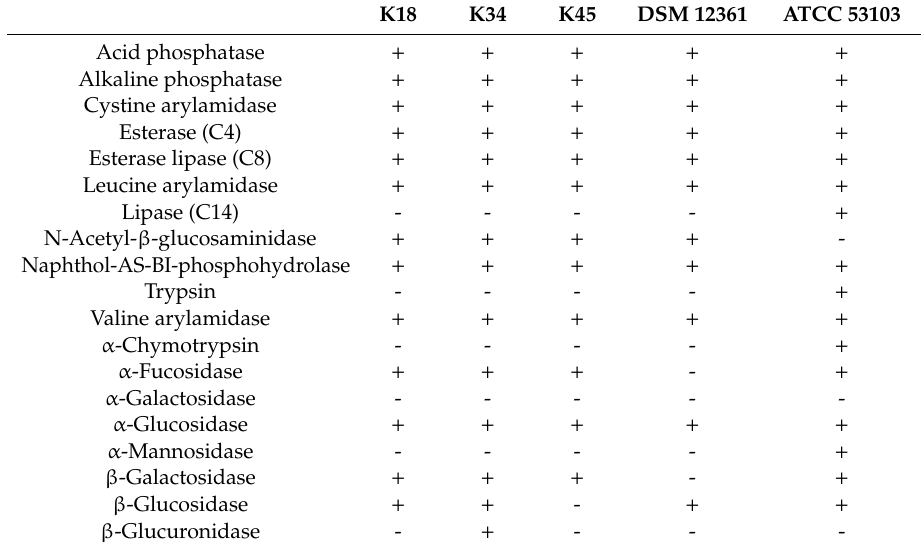
Table 1. Enzymatic profiles of A. kunkeei K18, K34, K45 and DSM 12361 and L. rhamnosus GG ATCC 53103 detected through API ZYM